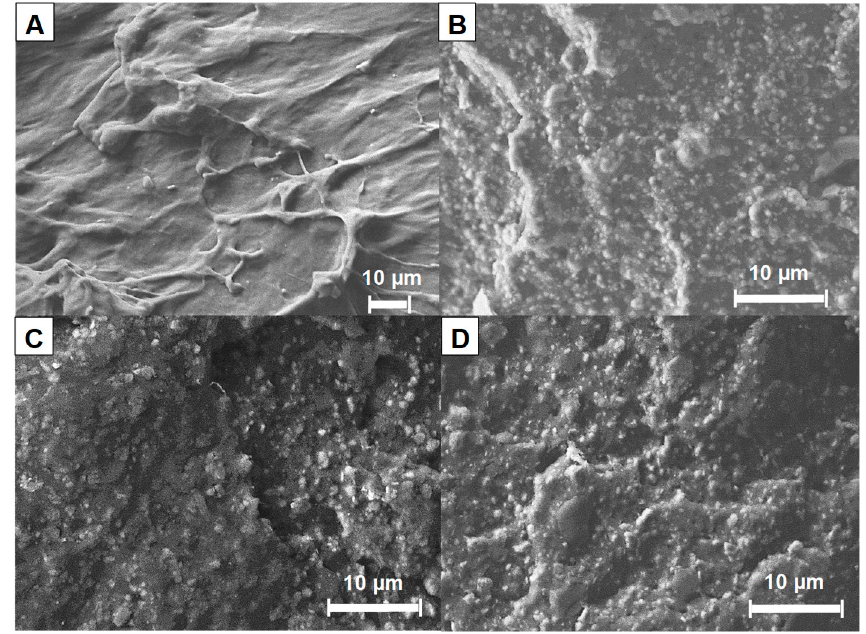
Figure 2. Scanning electron microscopy (SEM) micrographs of fractured surface for: ( A ) E-PE, ( B ) E-PE/185ATH, ( C ) E-PE/120ATH/15TRZ, and ( D ) E-PE/120ATH/15TRZ/3clay.